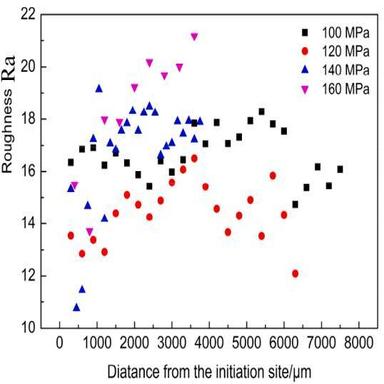
Variations of Ra for different stress levels.